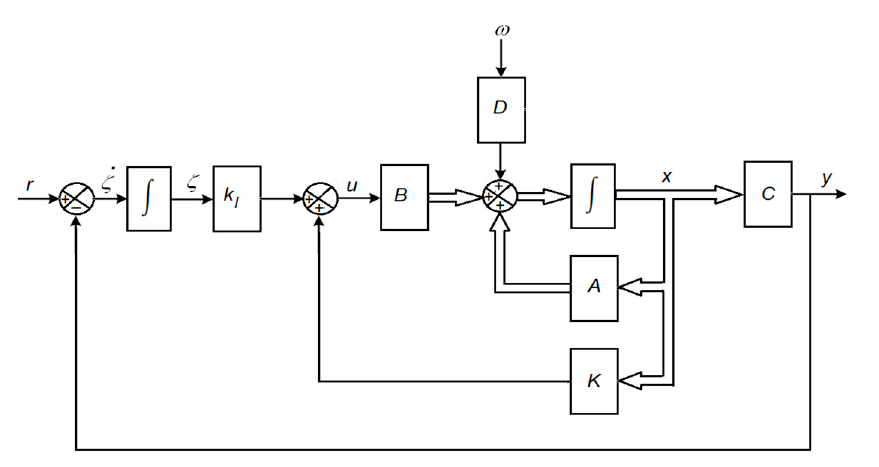
Figure 3. Servo Figure 3. Servo system.